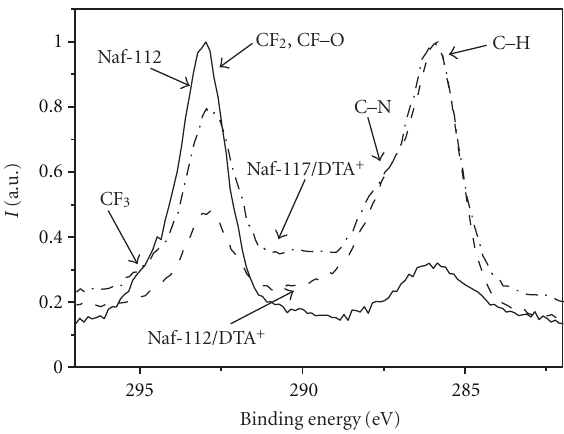
Figure 3: Comparison of the C 1s core level spectra obtained for Nafion-112, Naf-112/DTA + , and Naf-117/DTA + , membranes (both modified membranes after 48 h in contact with the